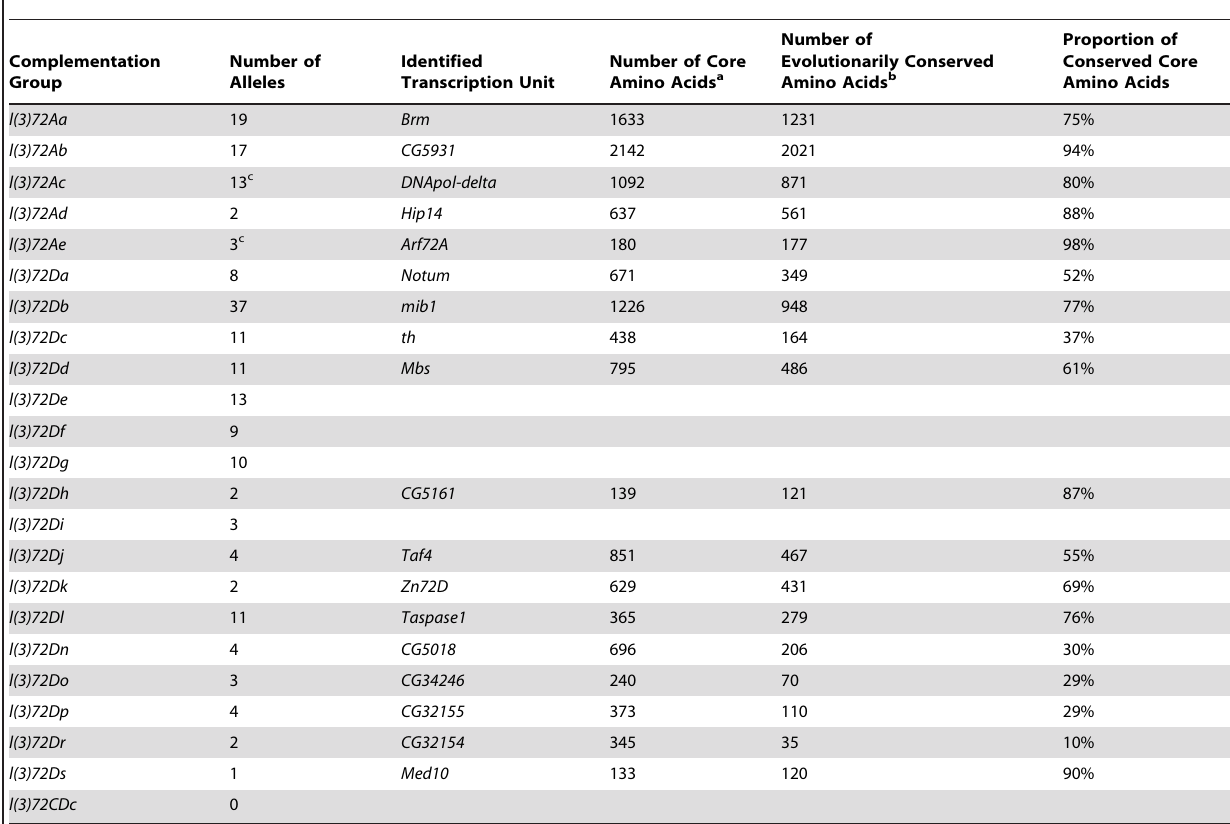
Table 1 . Complementation groups represented by the mutations within the Df(3L)th102 region of the genome.